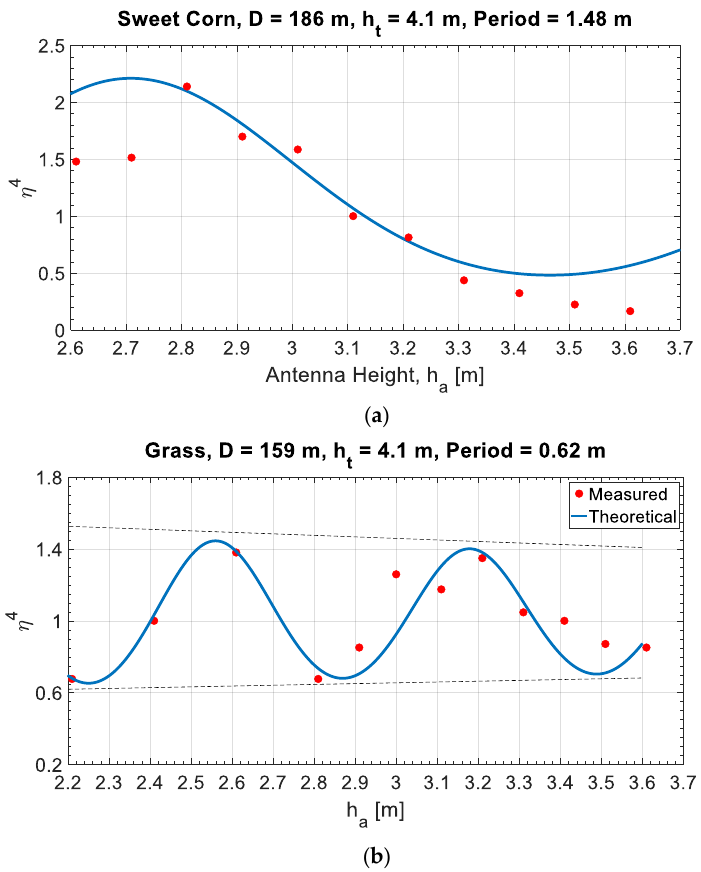
Figure 8. Measurement results. The period of the multipath effect is lower in propagation over grass ( b ) than over sweetcorn ( a ), due to the different height of the two kinds of vegetation.